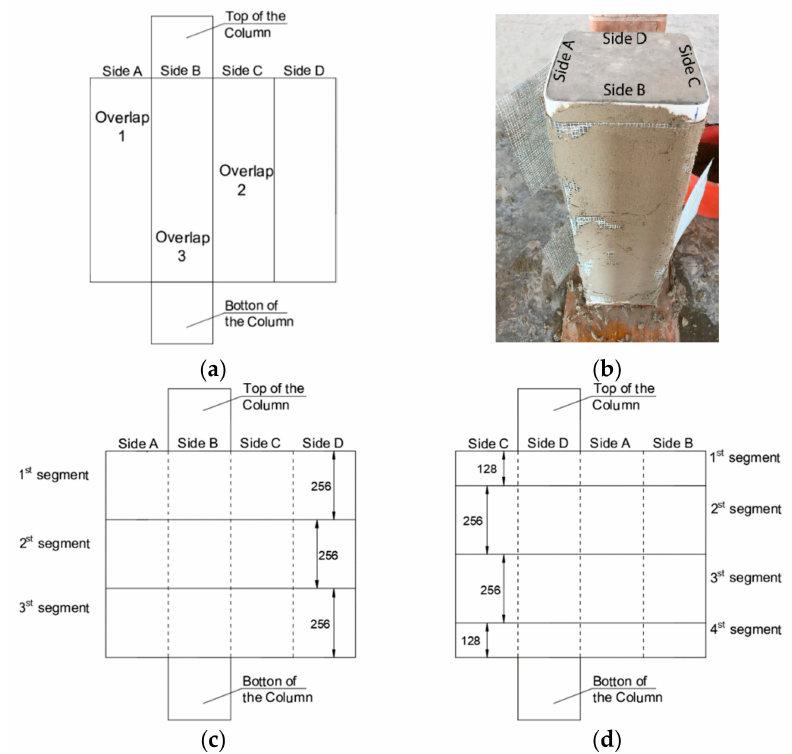
Figure 6. Overlap configuration ( a , b ) and, ( c ) position of the steel fabric segments along the height for specimens confined with one and three SRG layers and, ( d ) two SRG layers. (The dimensions are in